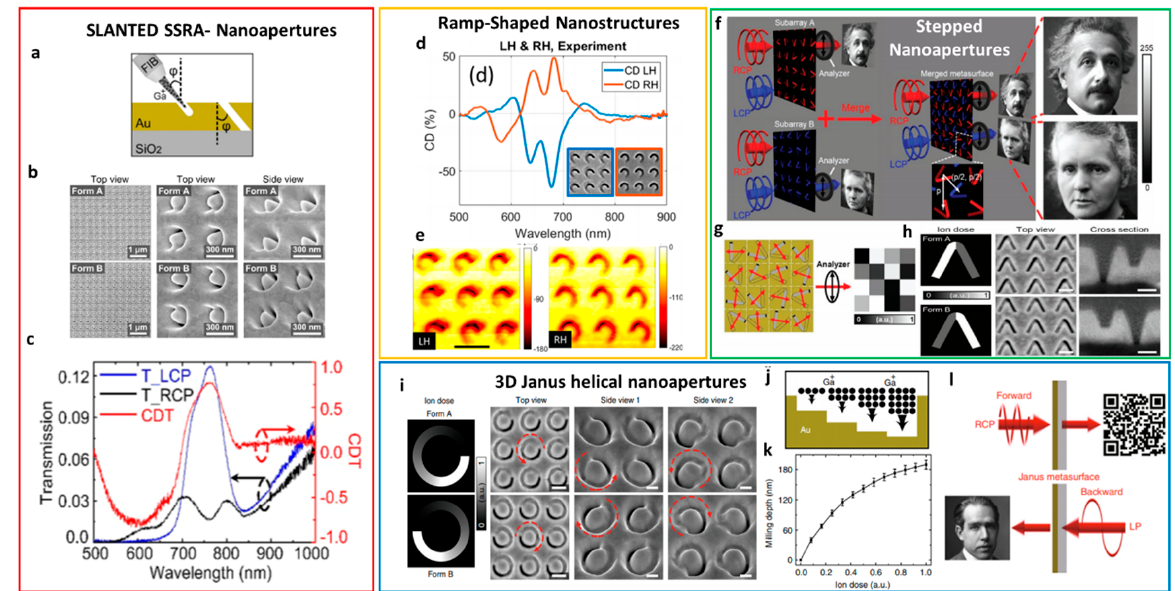
Figure 4. ( a ) Sketch of the tilted angle focused ion beam (FIB) process. ( b ) From left to right: SEM images of the slanted split ring apertures (SSRA) chiral metamaterials array in the two enantiomeric forms A and B; SEM images of the unit cell SSRA chiral metamaterials array in the two enantiomeric forms A and B; side view of SSRA chiral metamaterials realized with a slant angle of 40° in the two enantiomeric forms. ( c ) Measured transmission spectra of the SSRA chiral metasurfaces under LCP and RCP (L_LCP blue line and R_RCP, black line respectively) and the circular dichroism spectra (CDT, yellow line) calculated as CDT = (TLCP − TRCP)/(TLCP + TRCP). Reprinted with permission from [92]. Copyright © 2018, American Chemical Society. ( d ) Comparison between the measured circular dichroism of left (blue-line) and right (orange line)– handed nanostructures calculated as CD = L − R. The inset represents the top view of the SEM image of the ramp-shaped left and right-handed nanostructures. The structures have 100 nm of radius, a thickness of 200 nm and the period of the array is 600 nm. ( e ) Atomic force microscopy (AFM) images of the left-handed (LH) and the right-handed (RH) structures. The scale bar is 600 nm. In the images the darker pixels correspond to the deeper points. Reprinted with permission from [96] . Copyright © 2019, American Chemical Society . ( f ) Chiral grayscale subwavelength imaging design. The subarrays A and B are composed by two opposite stepped V-shaped nanoapertures enantiomeric forms. When interacting with circularly polarized light (CPL), if an analyzer is inserted after the metasurfaces to form the grayscale images, the subarrays form A can generate the grayscale portrait of Einstein while the form B can generate the grayscale portrait images of Marie Curie. ( g ) Schematic of grayscale intensity profile generated by an array of stepped V-shaped nanoapertures. The scale bar is 500nm. ( h ) Ion dose distribution and SEM images of the two enantiomeric forms of stepped V-shaped nanoapertures fabricated using the grayscale focused ion beam milling method. The cross-section images are acquired with a tilted angle of 42°. The scale bar is 200nm for the top view and 50 nm for the cross section. Reused with permission from [97]. ( i ) Ion dose distributions of the two enantiomeric forms of Janus 3D metasurfaces and SEM images of the fabricated 3D helical nanoapertures. The scale bar is 200nm. The side-view images are acquired with a tilted angle of 52°. The dashed lines indicate the growth direction of the groove. The scale bare is 100nm. ( j ) Schematic illustration of the ion dose distribution of grayscale focused ion beam milling method. ( k ) Graph of the milling depth as a function of the applied ion dose. ( l ) Janus metasurfaces work principle: In the forward direction, the right circularly polarized light is transmitted and displays a QR code, while in the backward direction, linearly polarized light gives back a grayscale image. Reprinted with permission from [94].